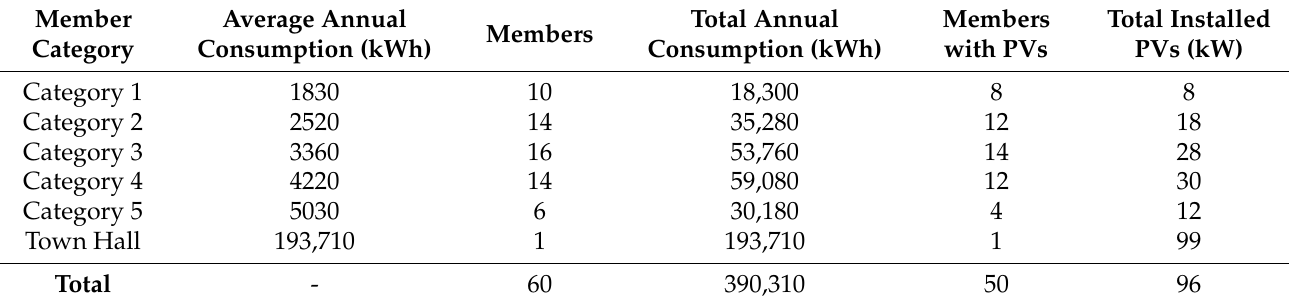
Table 1. Categorization of the energy community members and installed photovoltaics